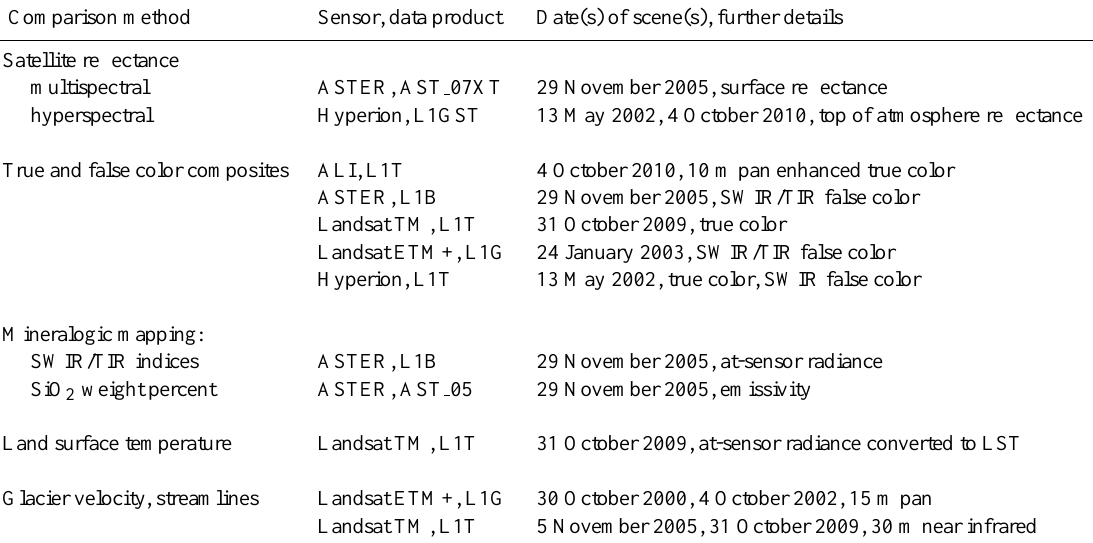
Table 2. A listing of the satellite products and scene dates used for the optical remote sensing methods evaluated in this study. Comparison